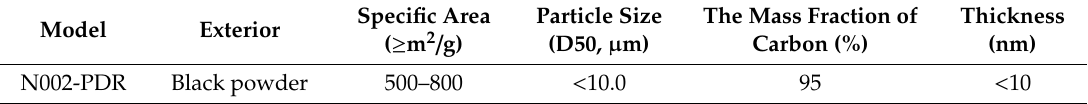
Table 1. The physical parameters of graphene.